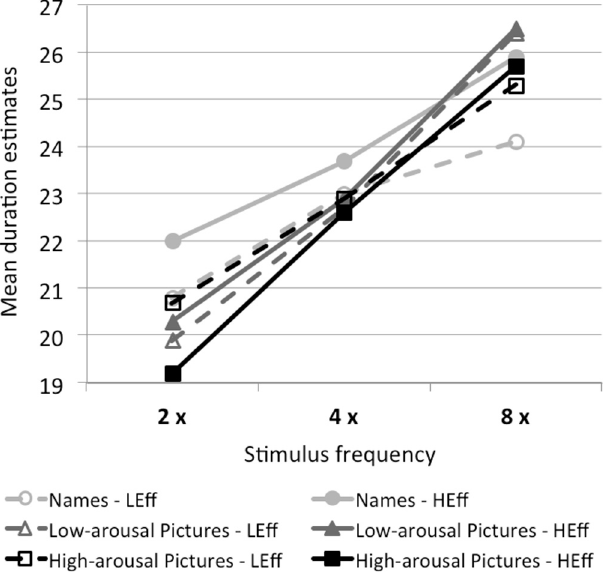
Fig 4. Influence of frequency on duration. Influence of stimulus frequency on duration judgments in the different stimulus-type and physical-effort conditions. Stimuli were presented two (2 x), four (4 x), or eight (8 x) times. Duration estimates are averaged per participant over the three levels of presentation duration. LEff = low physical effort; HEff = high physical effort. The figure displays a large frequency effect on duration in each attention